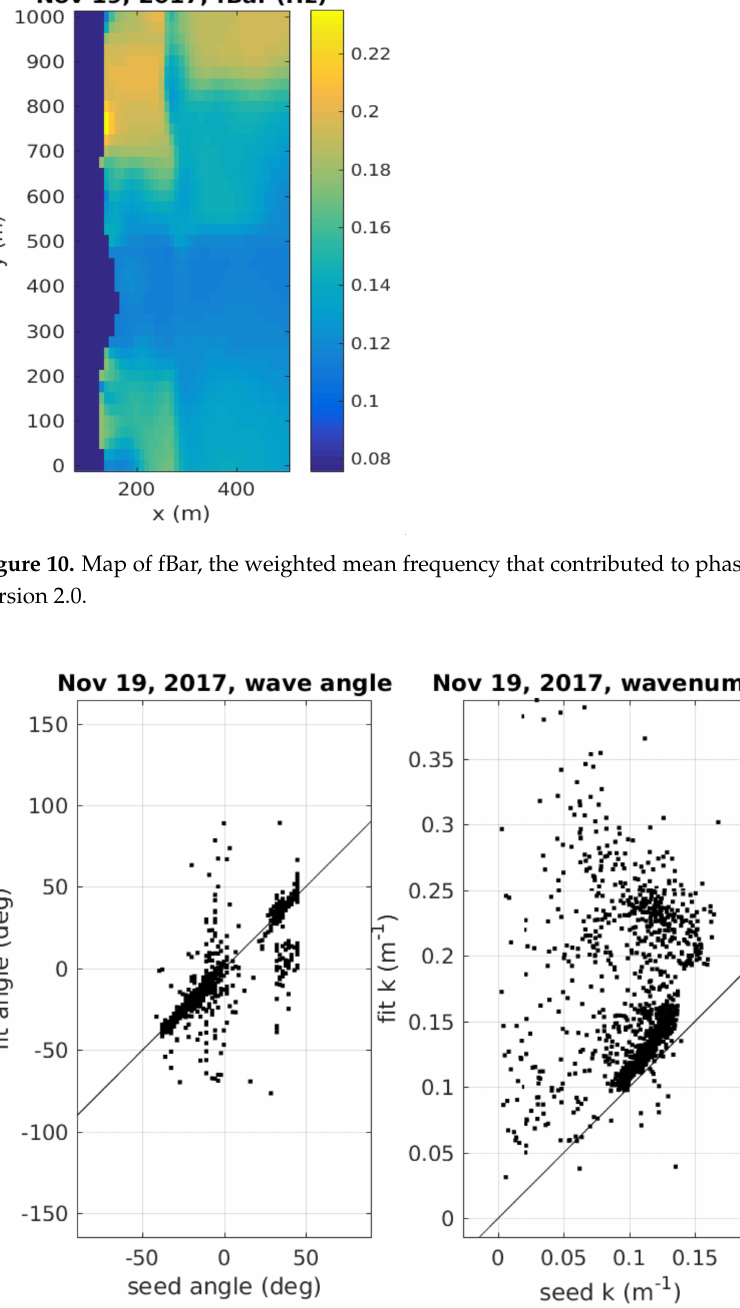
Figure 11. Comparison of seed wave angle and wavenumber to the final values from the nonlinear fitting routine. Example shows only values for the dominant